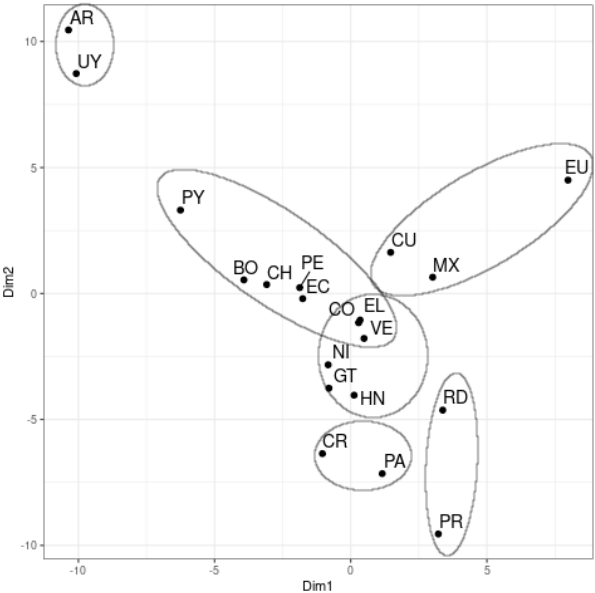
Figure 6 . PCA Plot Using the 148 Highest Ranked SVM